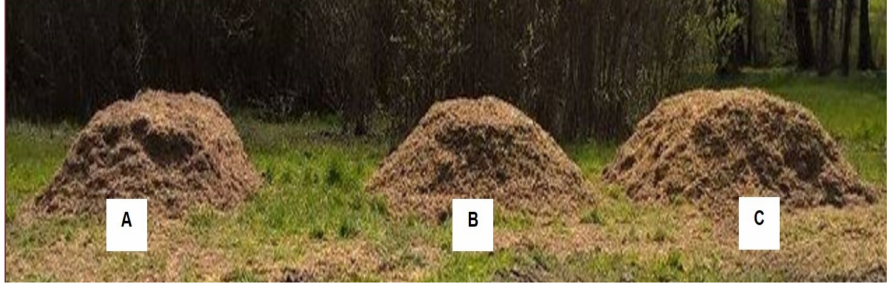
Figure 1. Different willow compost variants: ( A )—variant A (willow chips); ( B )—variant B (willow chips:hay, mass ratio 1:1 in d.m); ( C )—variant C (willow chips:hay:Nmin, mass ratio 1:1:0.04 in